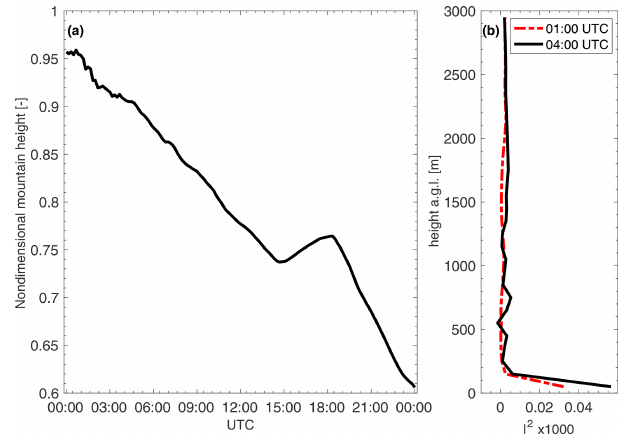
Figure 6. (a) Nondimensional mountain height as a function of time of day (UTC). (b) Scorer parameter at 01:00UTC (dashed red) and at 04:00UTC (solid) from model simulations.